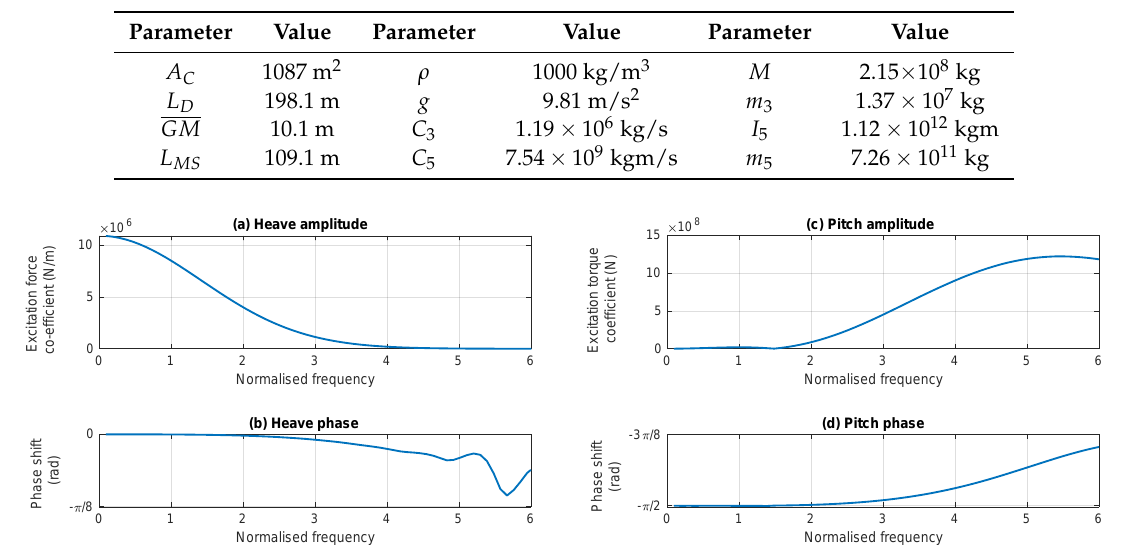
Table 1. Model parameter values used in the test case.